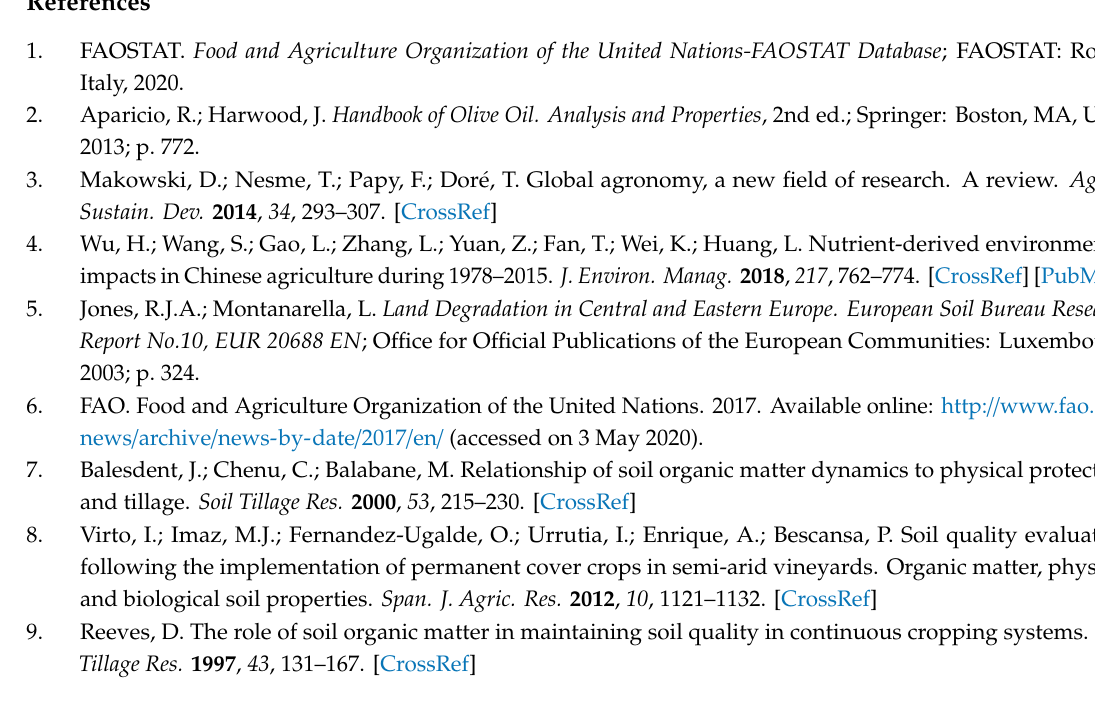
Figure S1 Olive fruit production percentage variation regarding season average for the olive trees studied seasons and the four treatments, Table S1: Average monthly temperature (Celsius degrees) from 2013 to 2018 in the studied area, Table S2. Monthly rainfall (mm) from 2013 to 2018 in the studied area, Table S3. Spring (March, April and May) average temperature (Celsius degrees) and accumulated rainfall (mm) from each crop season, Table S4. Measured field parameters in 2017 for the di ff erent treatments, Table S5. Regulated olive oil parameters for the di ff erent treatments in 2017, Table S6. Leaf nitrogen content for the di ff erent treatments and years. Average ± standard